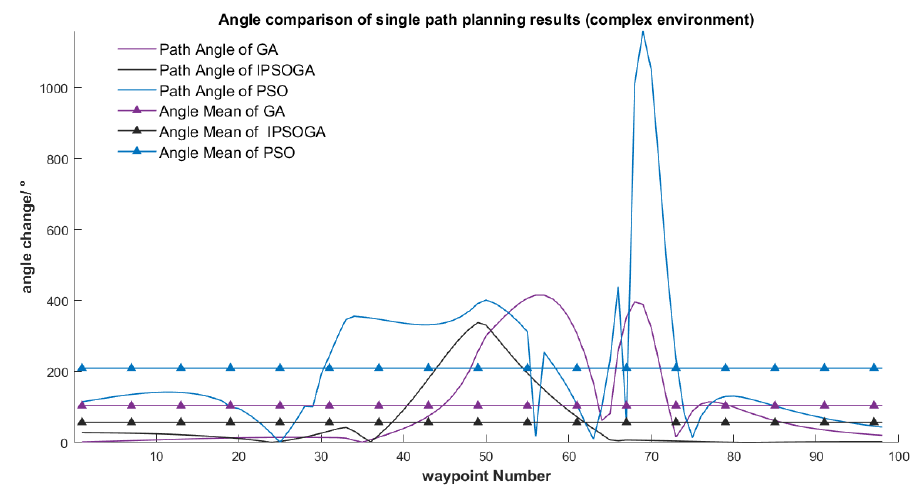
Figure 12. Comparison of path angle (complex environment).